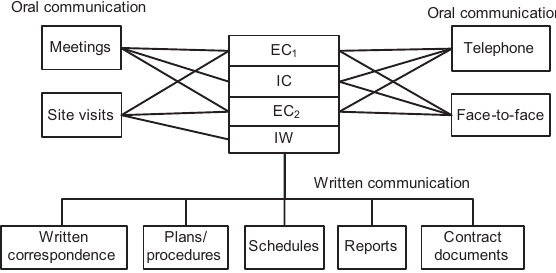
Fig. 2. Relationships between coordination needs and